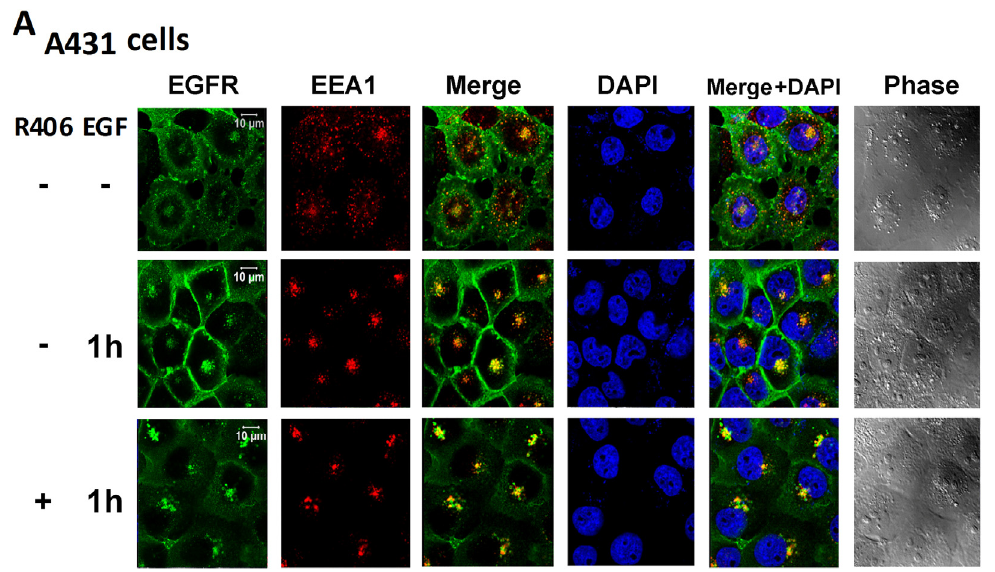
Figure 5. Figure 5. Cont .